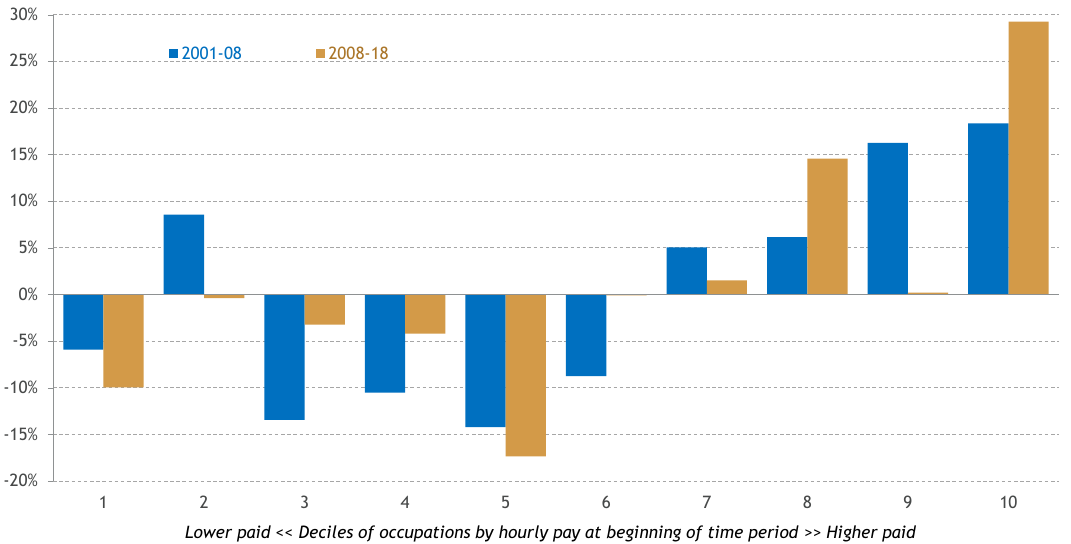
Figure 19: There has been little change in the shape of occupational change in the past decade Percentage change in employment